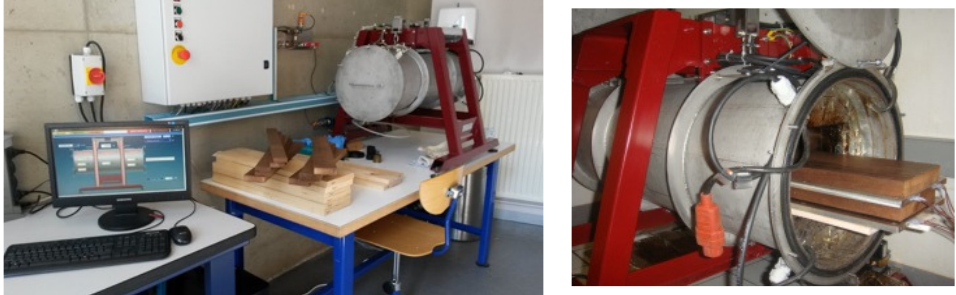
Figure 1. Conductive vacuum reactor.